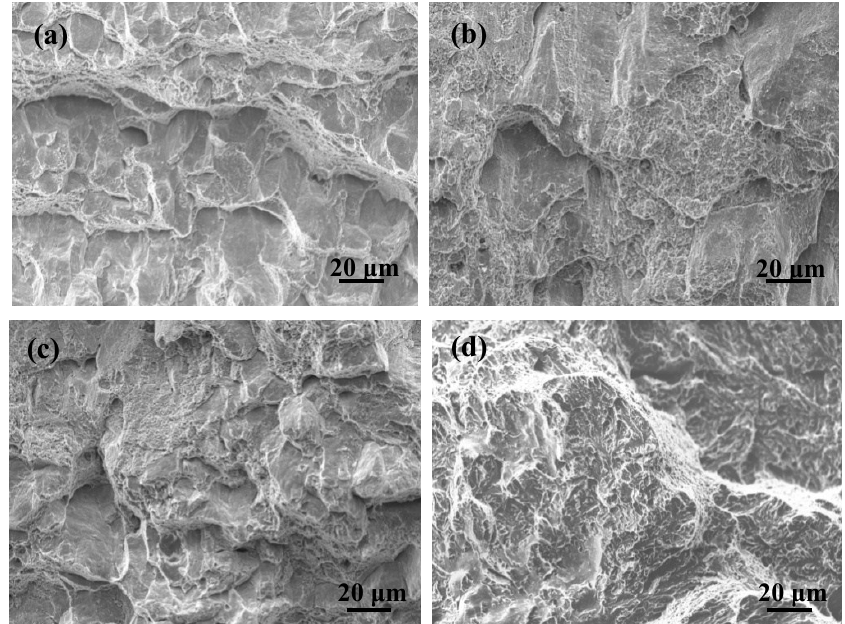
Figure 9. The typical fracture morphology of H13 steel ( a ) 1# ingot with 0% REM; ( b ) 2# ingot with 0.015% REM; ( c ) 3# ingot with 0.025% REM; ( d ) 4# ingot with 0.1%